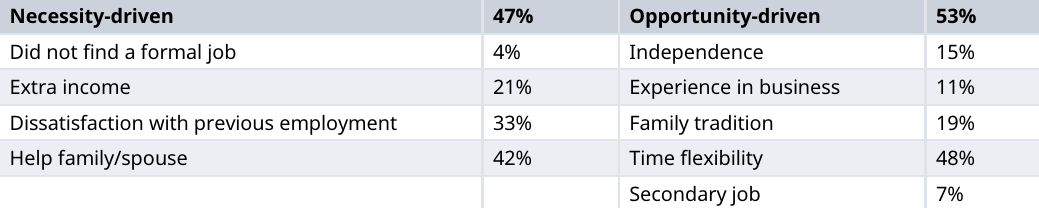
Table 2. Motives of informal entrepreneurs.